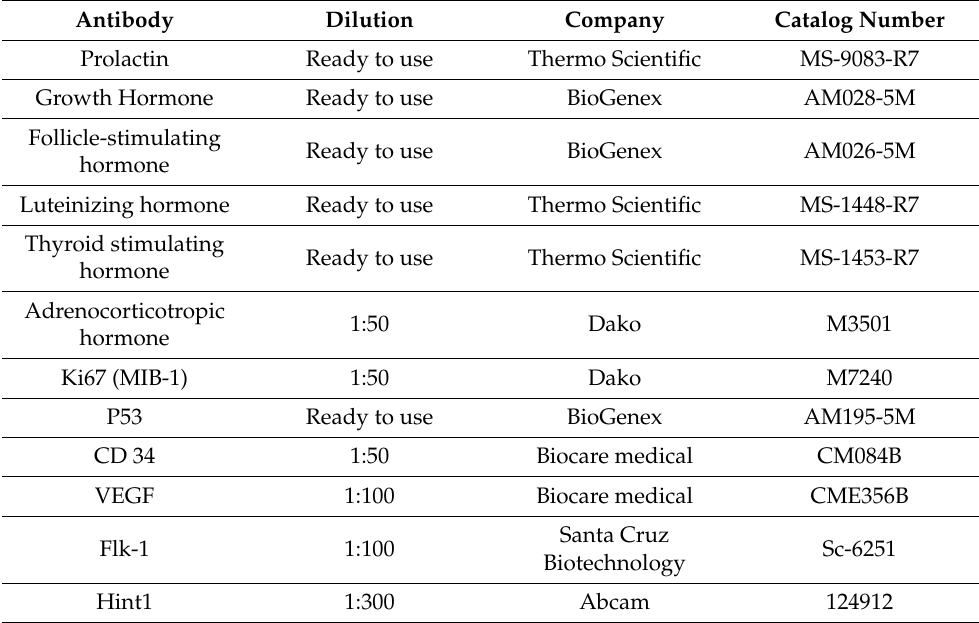
Table 1. Antibodies used in immunohistochemical